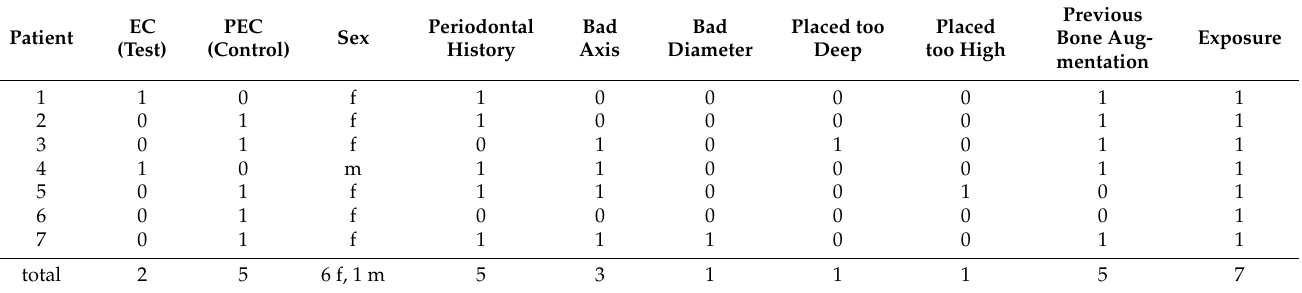
Table 2. Explanted